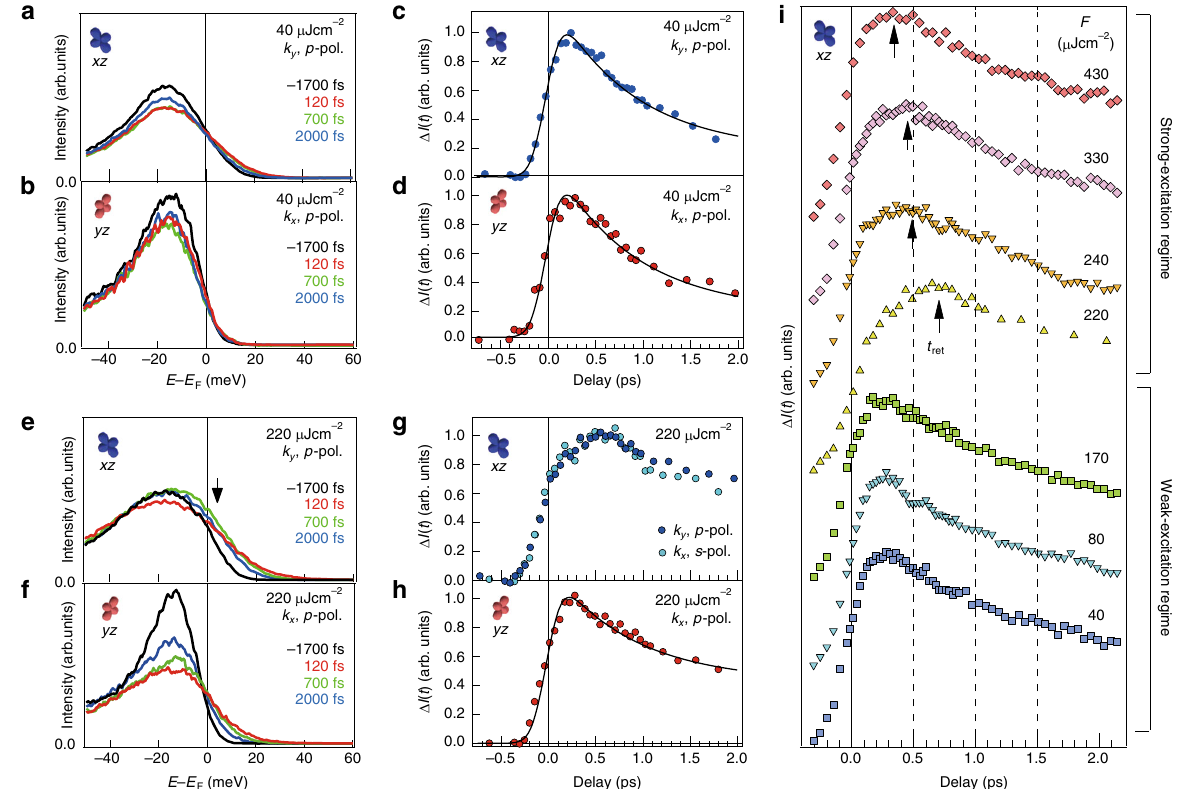
Fig. 3 Orbital-dependent dynamics of the photoexcited electrons at the Γ point. a EDCs around the Γ point ( k = 0.0 ± 0.04 Å − 1 ) obtained from the E – k images at 20 K along k y at t = − 1700, 120, 700, and 2000 fs, in the p -polarized setting. The fl uence of the photo-excitation was F = 40 μ J cm − 2 . b The same as a but obtained along k x axis. xz ( yz ) electrons are dominantly observed in a ( b ). c The photo-electron intensities normalized by that before photo- excitation, Δ I ( t ), at the α band top ( E − E F = 7.5 ± 2.5 meV) around the Γ point ( k y = 0.0 ± 0.04 Å − 1 ), obtained by the p -polarized probe laser and the pump fl uence of F = 40 μ J cm − 2 . The black curve represents the fi tting function assuming the double exponential components with the time constants of 850 fs and 80 ps. d The same as c but at k x = 0.0 ± 0.04 Å − 1 . e – h The same as a – d but with the pump fl uence of F = 220 μ J cm − 2 . The light blue markers in g represent the Δ I ( t ) of xz obtained by an s -polarized probe laser (Supplementary Note 4). i F dependence of the normalized Δ I ( t ) for xz . The black arrows represent the time of the retarded maxima t ret for F > F c